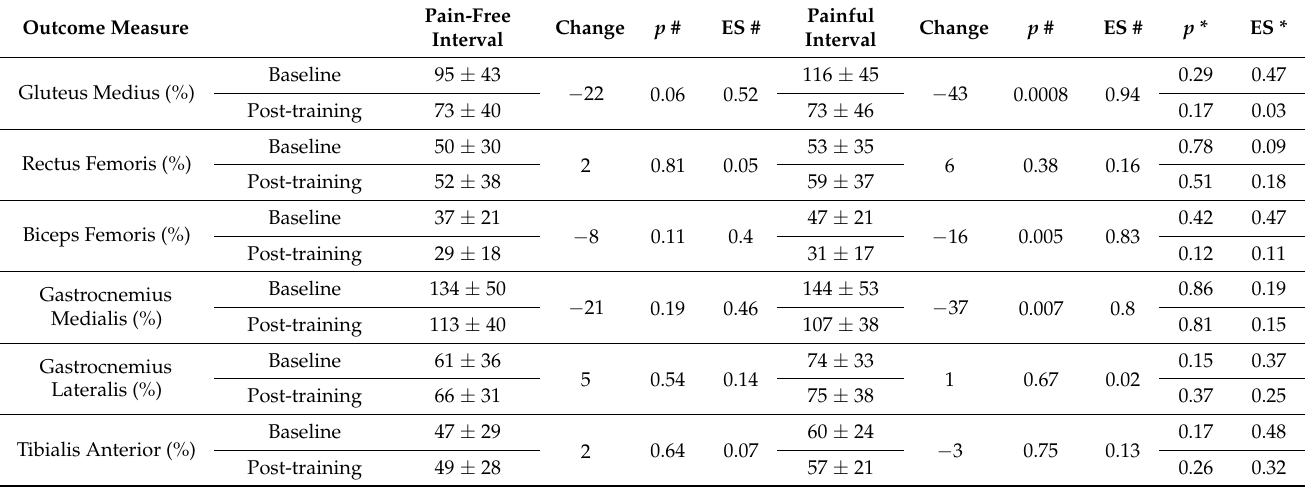
Table 1. Comparison of average mean amplitude of sEMG signal in pain-free and in painful intervals of the treadmill test.